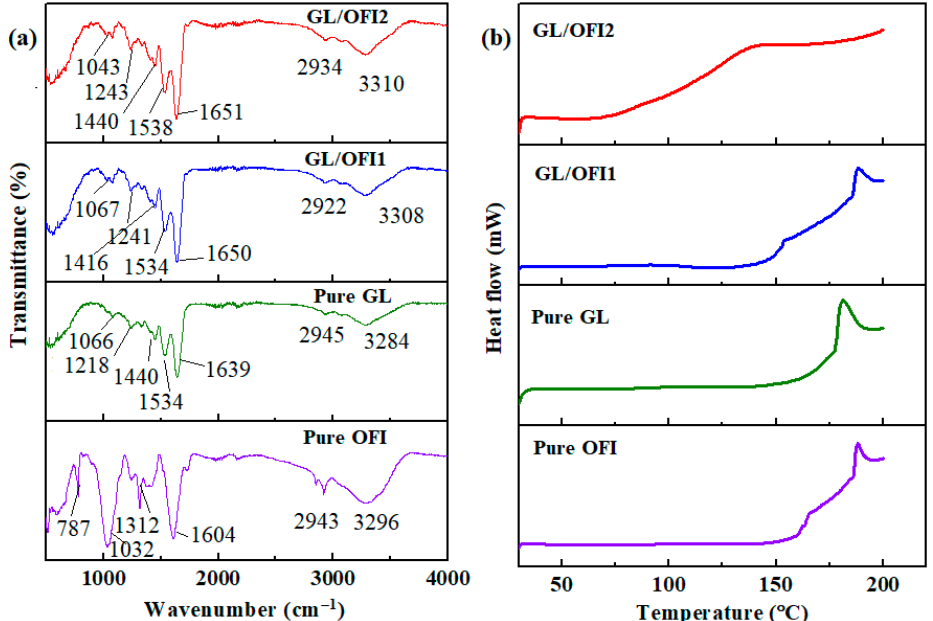
Figure 4. ( a ) FTIR spectra and ( b ) DSC curves of pristine GL, pure OFI, GL/OFI1 nanofiber, and GL/OFI2 nanofiber, respectively.